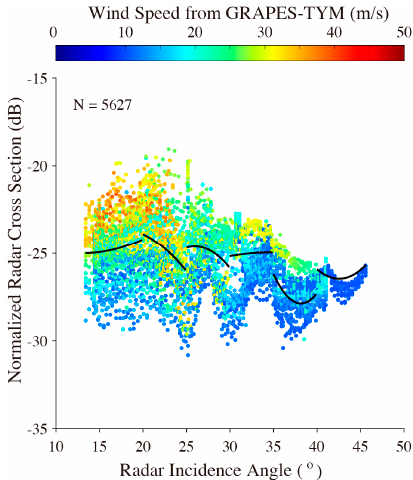
Figure 6. NRCS of entire VH-polarization GF-3 SAR image versus collocated radar incidence angle, in which the black lines represent the fitting results between VH-polarization GF-3 NRCS and radar incidence angle.